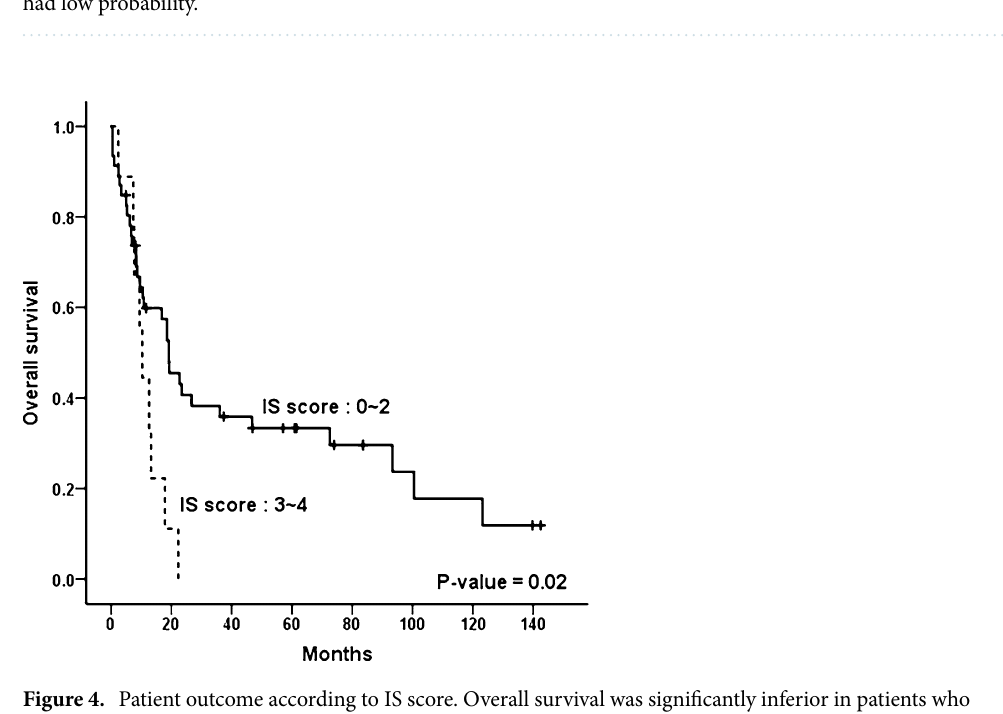
Figure 3. Flowchart using FDG PET/CT pattern and metabolic parameters to differentiate TIME subtype. Subjects with only nasal involvement had non-IS types in all but one case. In the extra-nasal lesion group,